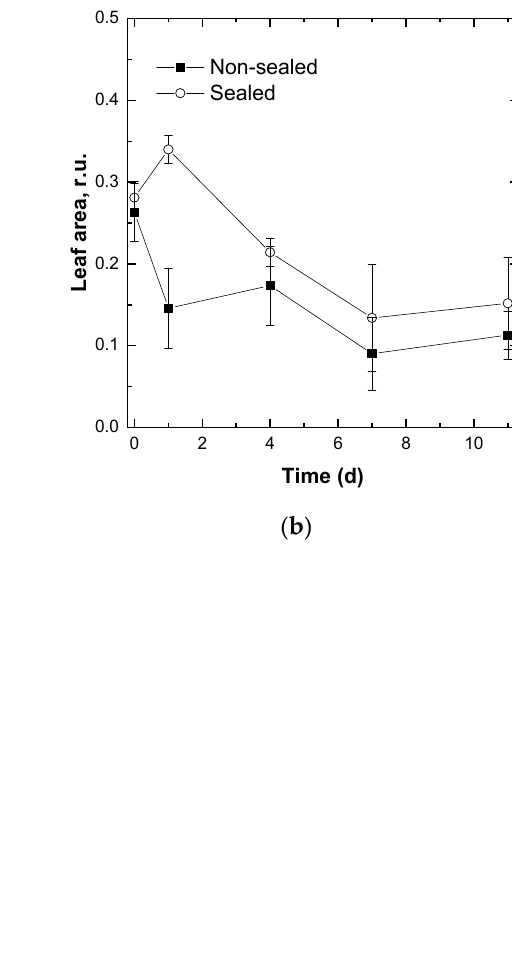
Figure 4. Changes in pigment composition during storage of the non-sealed (closed symbols) and sealed (open symbols) fresh-cut lettuce leaves. ( a ) Time-course of [Chl]. ( b ) Time-course of [Car] changes. ( c ) Relationship between total and [Chl] changes. ( d ) Changes of [Car]/[Chl] mass ratio plotted vs. changes in [Chl]. Average ± SE values are presented ( n = 9).